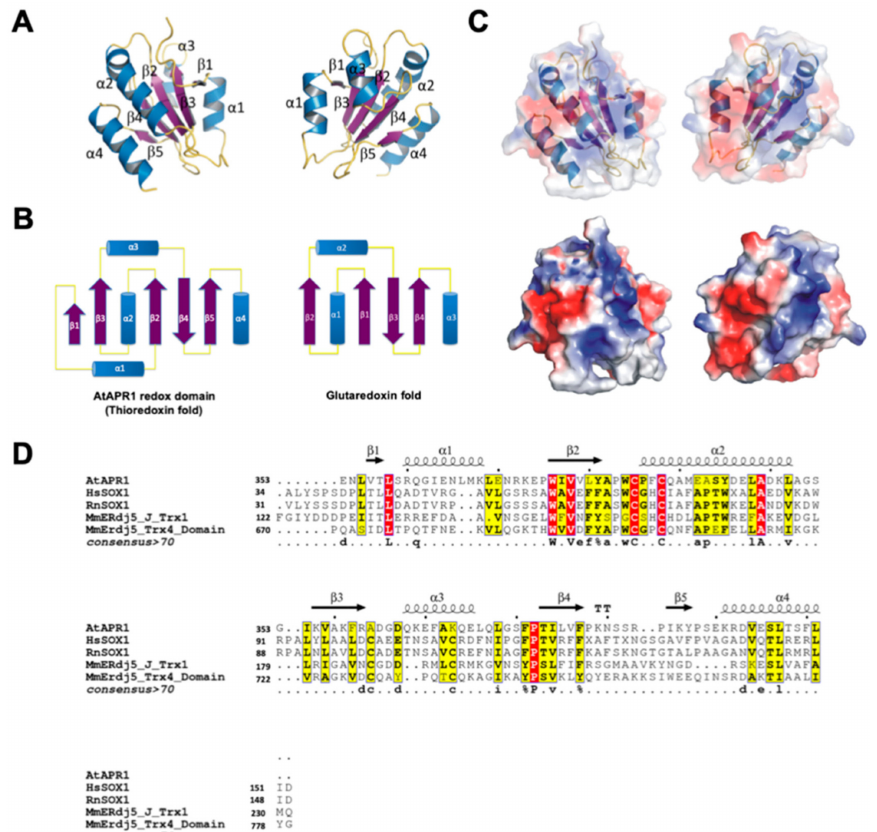
Figure 2. Crystal structure of the C-terminal redox domain of AtAPR1. ( A ) Structure of the AtAPR1 redox domain displays a typical thioredoxin fold with a central five-stranded β -sheet ( β 1– β 5) and four flanking α -helices ( α 1– α 4). Helices, strands, and loops are shown in blue, purple, and yellow, respectively. ( B ) Topology diagram of the AtAPR1 redox domain and glutaredoxin fold. ( C ) The electrostatic surface potentials mapped with red patches and blue patches represented as negative and positive charge, respectively. ( D ) Structure-based sequence alignment of the AtAPR1 redox domain with other structural homologs. Selected proteins shown in alignment are human sulfhydryl oxidase 1 (hsSOX1; PDB code: 3Q6O), rat sulfhydryl oxidase 1 (RnSOX1; PDB code: 4P2L), mouse ER-resident protein disulfide reductase (MmERdj5) J-Trx1 fragment (PDB code: 3APQ), and mouse ER-resident protein disulfide reductase (MmERdj5) TRX4 domain (PDB code: 3APS). Identical residues are in white and the frame is in red. Amino acids with similarity score > 0.7 are framed in yellow. Secondary structure of the AtAPR1 redox domain is drawn above the alignment with arrows as sheets and strings as helices.